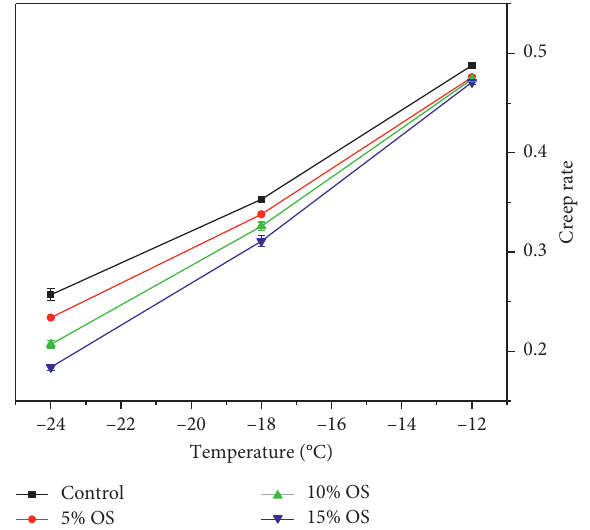
Figure 11: m -curve of asphalt binder for studied materials at low